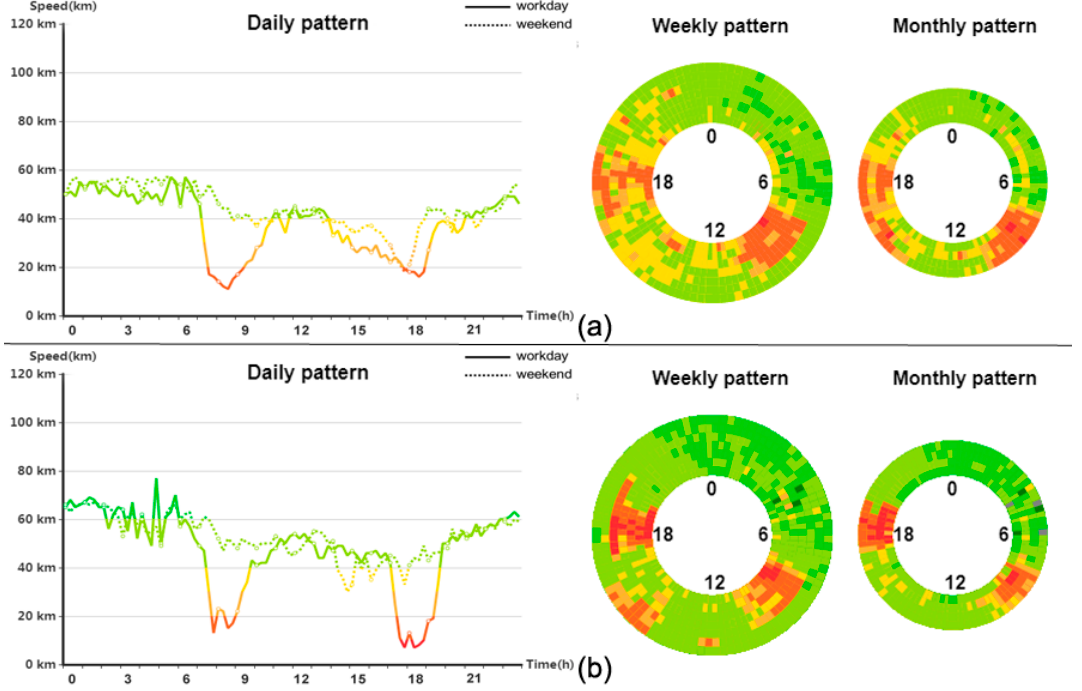
Figure 4. Temporal view of traffic patterns. ( a ) One road link. ( b ) Another road link located on the same road with opposite driving direction.